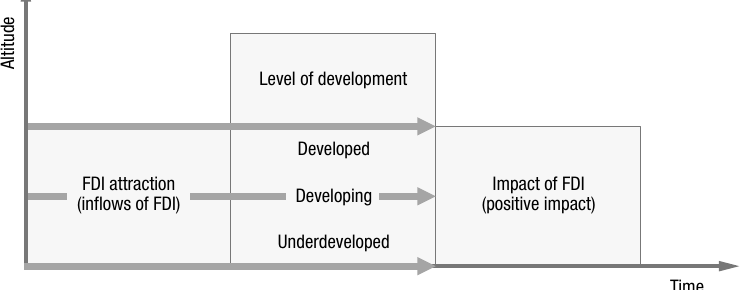
Fig. 1. Generalization of